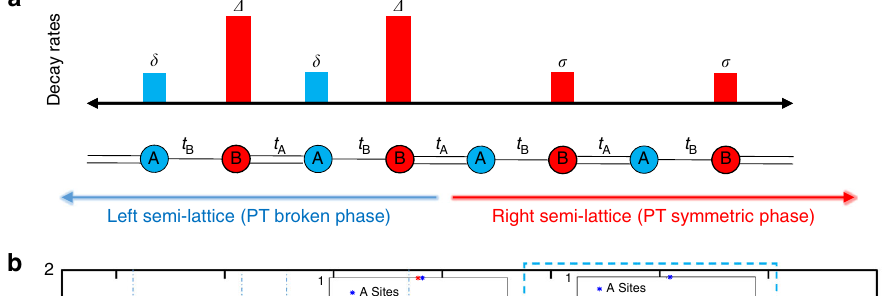
right lattice, the edge state in the right lattice reemerges as a localized zero mode at the parity-preserving termination site (i.e., the interface site) 37,39 . Because there is no real energy interaction at this interface, the zero-energy state can also be regarded as a state inherited from the fl at band in the left lattice. As a result, a robust photonic zero mode emerges with the fi eld strongly localized at the interface waveguide between two semi-lattices. In its Hermitian limit, the structure cannot support the zero mode because we interface two semi-lattices with the same topological order. Therefore, the zero-energy mode is driven by the PT phase